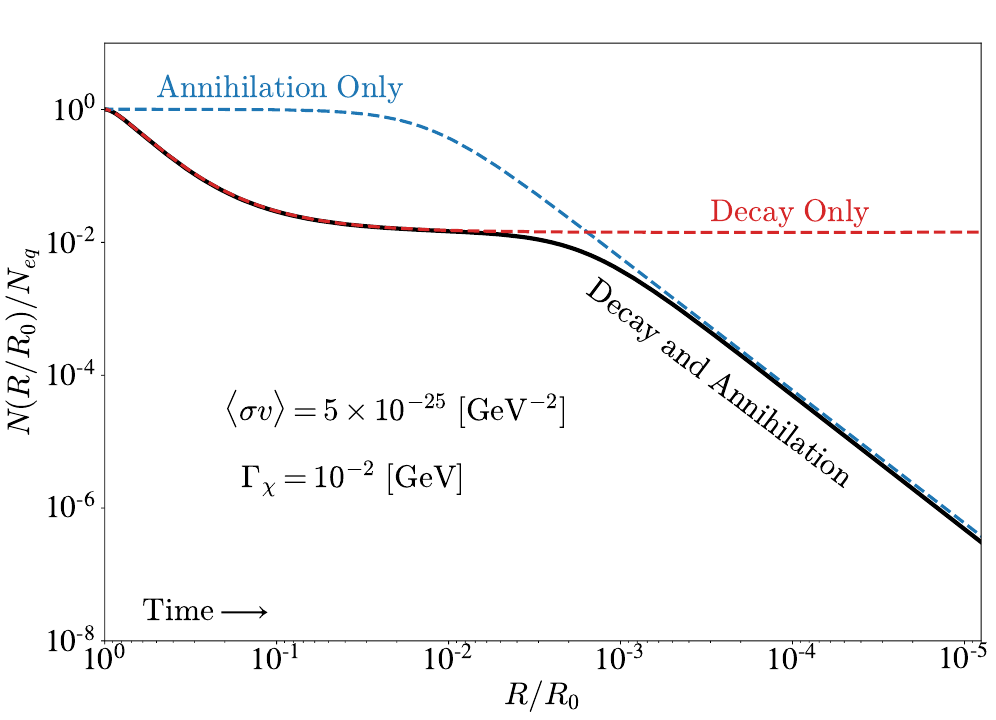
Figure 2 . Example of χ evolution during the pocket collapse, showing the fraction of the χ that are present at different radii as the pocket collapses in cases where only decay processes are present (red), only annihilation processes are present (blue), and both decay and annihilation processes are present